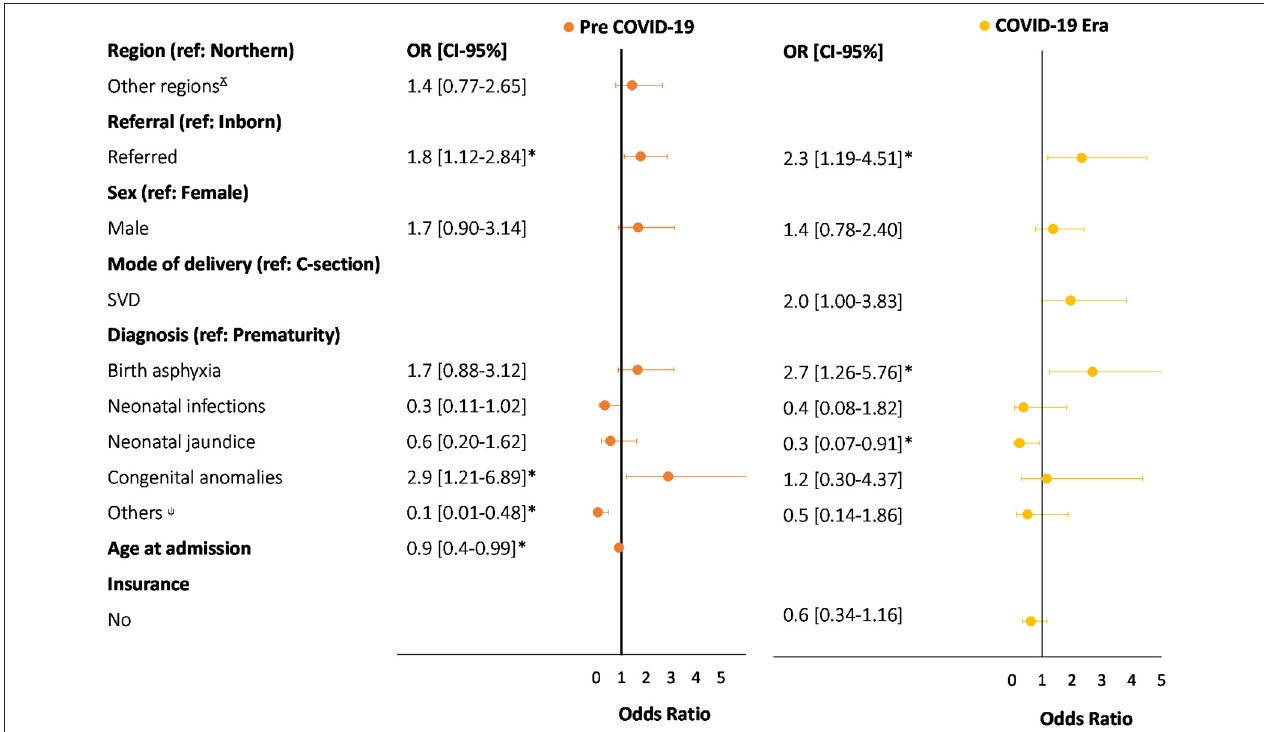
FIGURE 3 | Comparison of multivariate logistic regression for predictors of neonatal death between pre-COVID-19 and COVID-19 era in LBW neonates ( < 2,500g) in TTH NICU. *Statistiscally significate ( p < 0.05). È Includes: Ashanti, Bono, Bono East, North East, Oti, Savannah, Upper East, Upper West. ψ Includes: pemphigous, dehydration, meconium aspiration syndrome, respiratory distress syndrome, retro-exposed, malnutrition, normal baby, stable baby, birth injuries, hematological diseases, neonatal seizures, low birth weight, and macrosomia. Pre-COVID-19 was defined as neonatal admissions from March 1st to August 31st, 2019. COVID-19 era was defined as neonatal admissions from March 1st to August 31st,